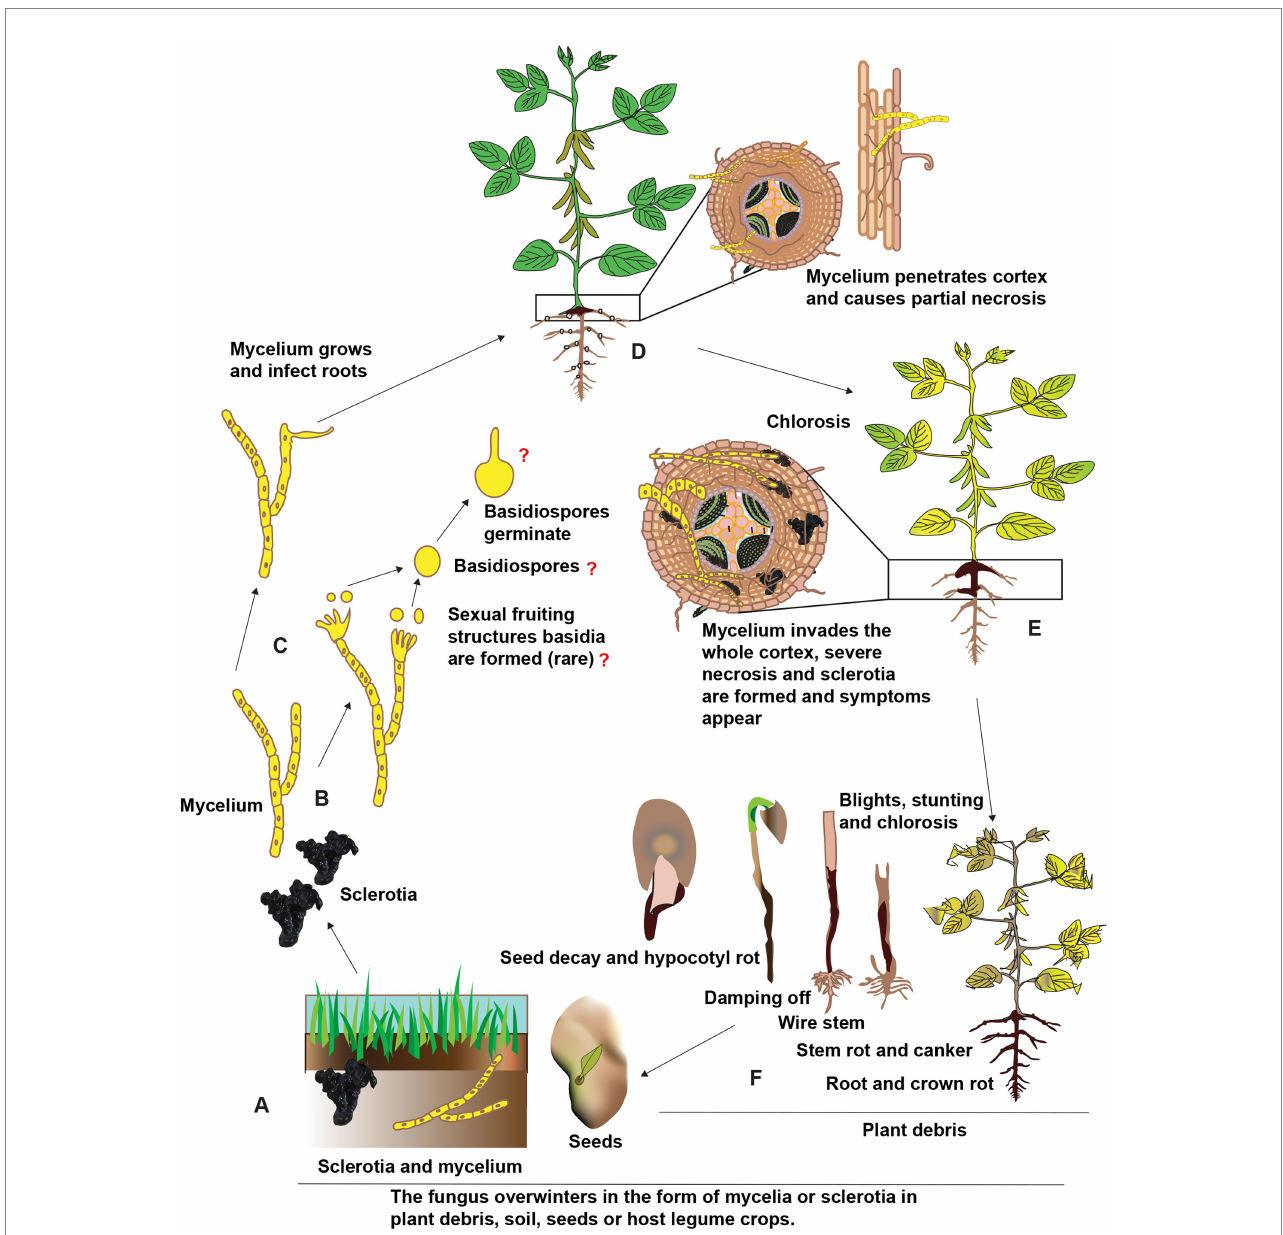
FIGURE 3 Schematic representation of the presumed disease cycle of R. solani on legume crops. (A) The fungus overwinters in the soil as sclerotia and mycelium as well as in plant debris and seeds in the form of mycelium. (B,C) Under favorable environmental conditions, the immature hyphae germinate and grow, although sexual fruiting structures like basidia and basidiospores are uncommon. (D) The mycelium penetrates roots near the soil line and is colonized in inter and intracellular spaces. (E) The mycelium proliferates further in the cortex ultimately resulting in necrosis finally, sclerotia are formed in and on infected tissues and different symptoms appear on stems and roots of different legume crops. (F) Above-ground symptoms include chlorosis, blights, stunting, and finally death, the fungus also infects seeds and seedlings causing seed decay, damping-off, and other symptoms. Reconstructed from Abbas et al.